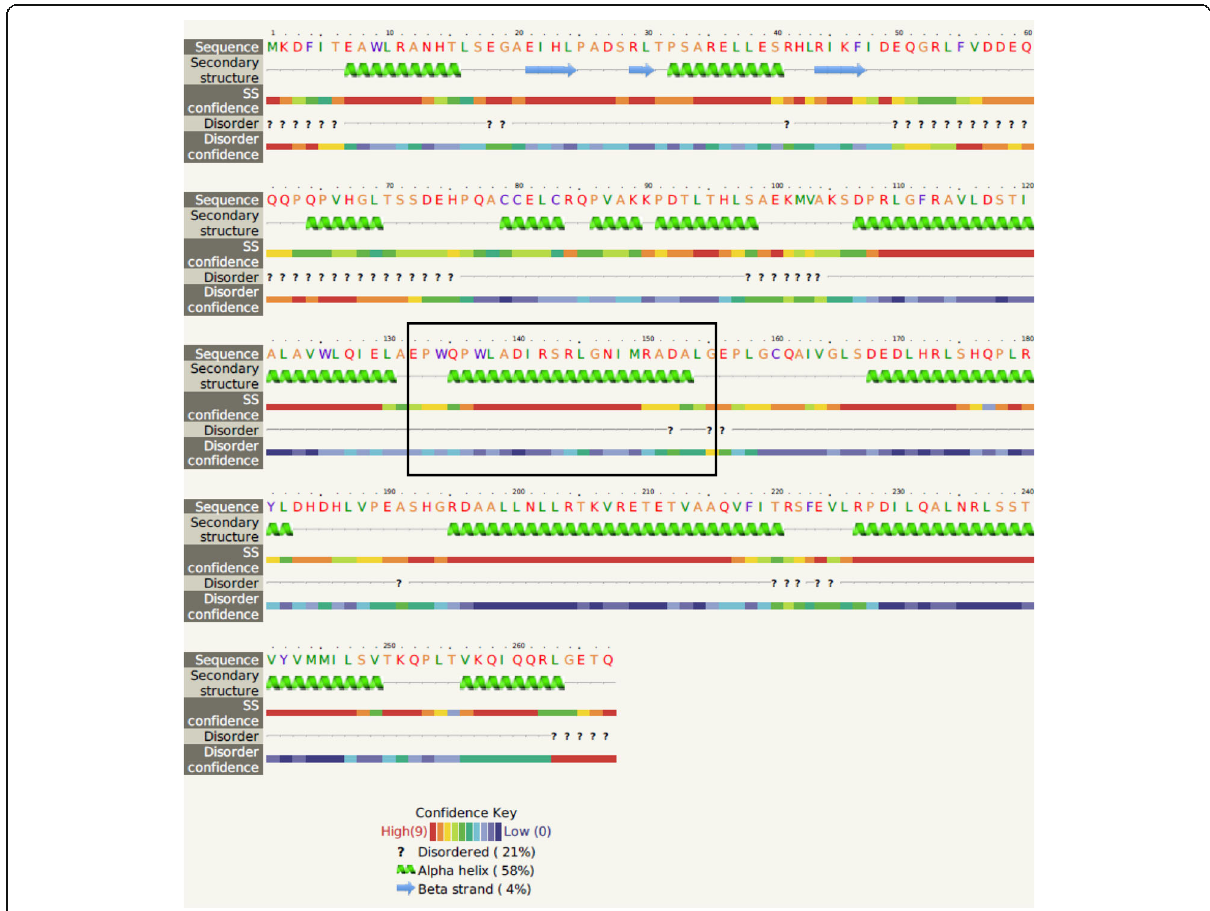
Fig. 3 Predicted secondary structure modeling of the EutT protein of E. coli BG1 obtained with Phyre version 2.0